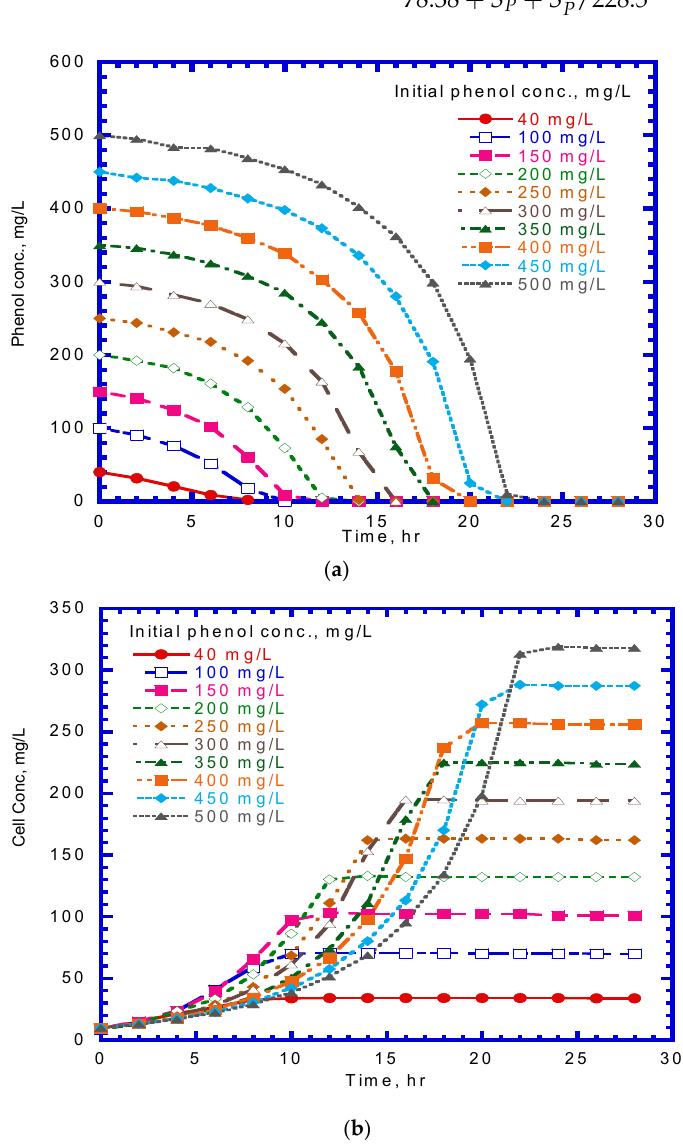
Figure 3. Effect of initial phenol concentration on ( a ) phenol degradation and ( b ) cell growth.